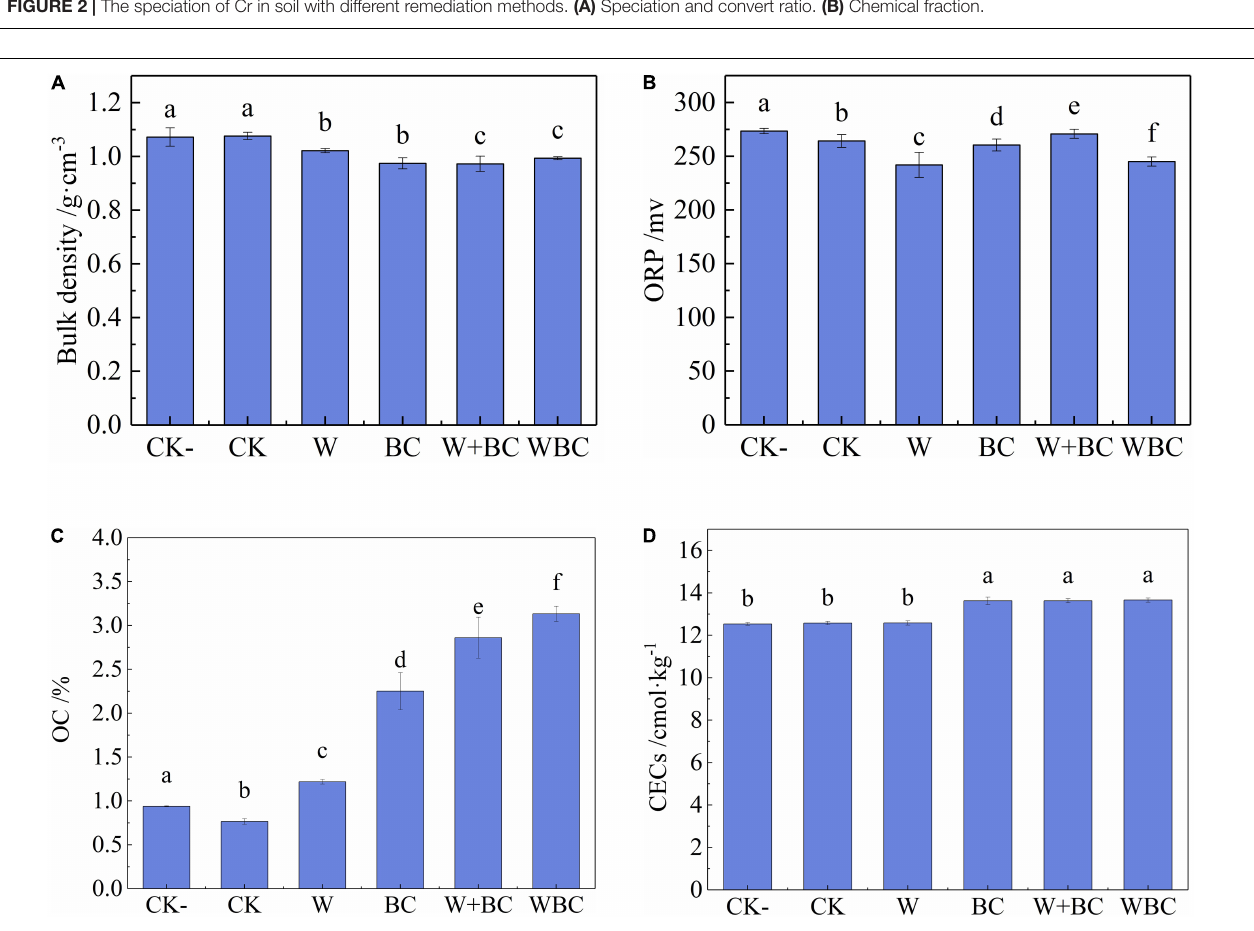
FIGURE 2 | The speciation of Cr in soil with different remediation methods. (A) Speciation and convert ratio. (B) Chemical fraction.